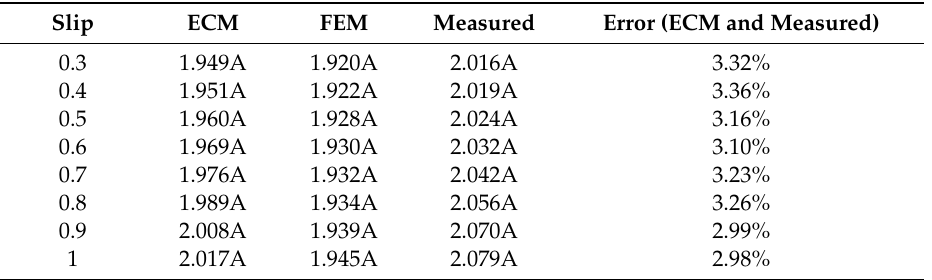
Table 6. Stator current comparison result.